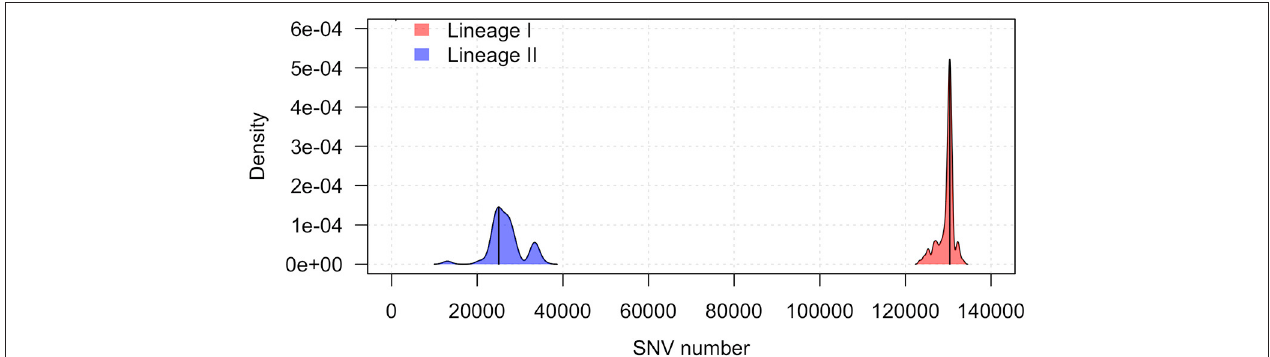
FIGURE 1 | Kernel density plot of the SNV distribution per lineage taking the JF4839 strain from lineage II as a reference. Black lines represent the mode of the data. Differences between lineages were significant ( p -value < 0.0001, Mann-Whitney-Wilcoxon test).